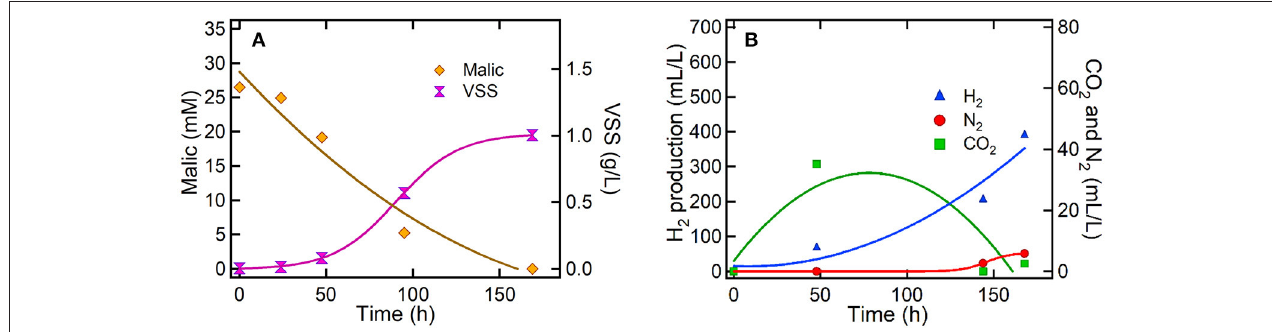
FIGURE 5 | Culture of PPB under bio-electrochemical conditions at − 0.5V (vs. Ag/AgCl) (A) Malic acid removal and PPB growth and (B) production of H 2 , N 2 , and CO 2